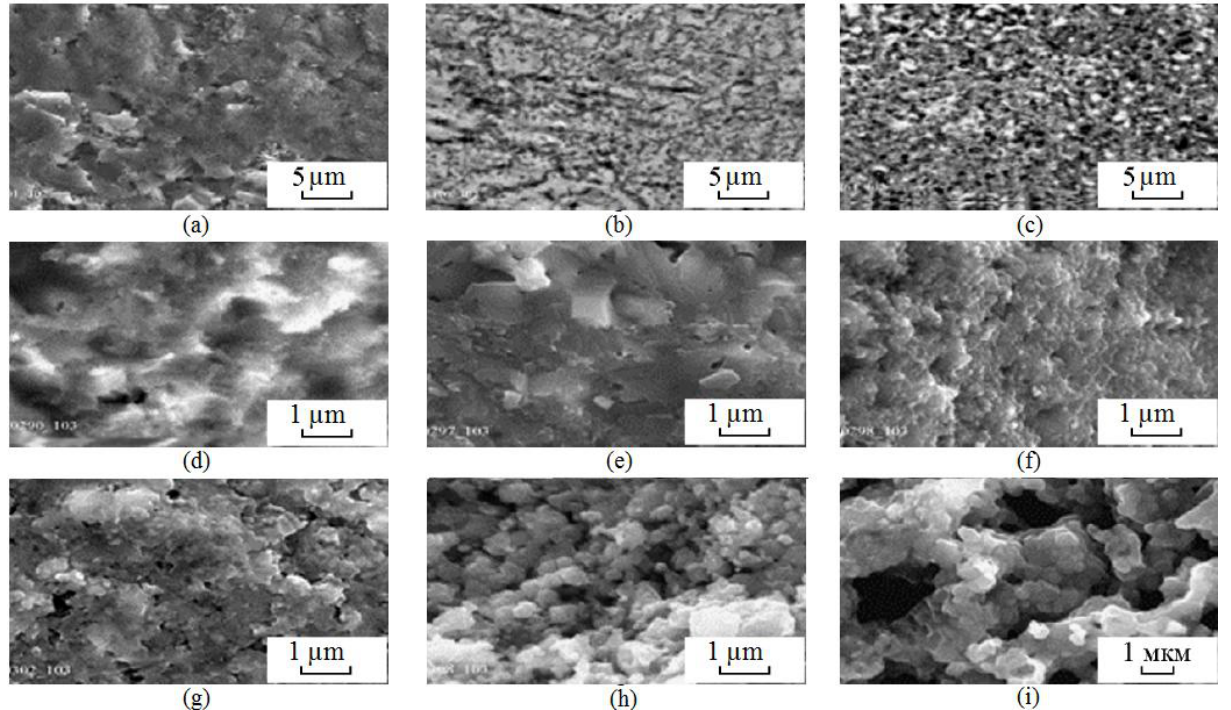
; ( c ) 60% ТiB . SPS: ( d ) 20% ТiB 2 2 , Тs = 1400 °C; ( g ) 36% ТiB 2 , and Ts = 1400 2